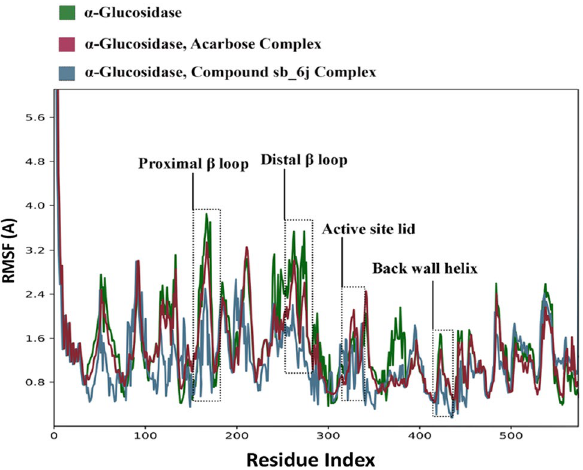
Figure 7. The RMSF values of α-glucosidase, acarbose- α-glucosidase and compound 6j in complex with